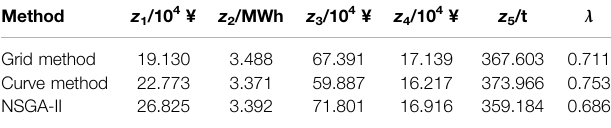
TABLE 4 | Comparisons of the COSs by different methods.